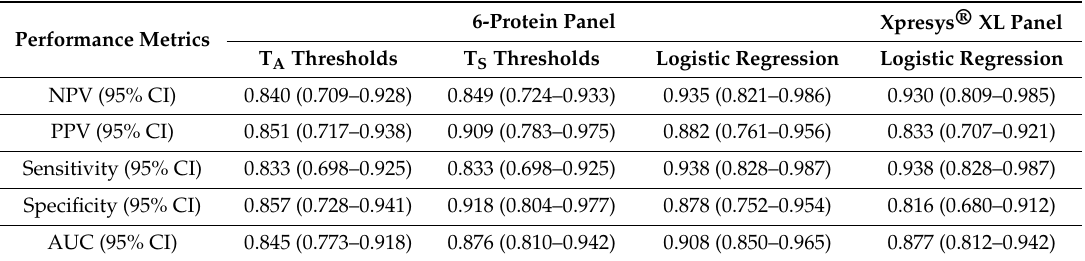
Table 4. Performance of the classification models on the validation